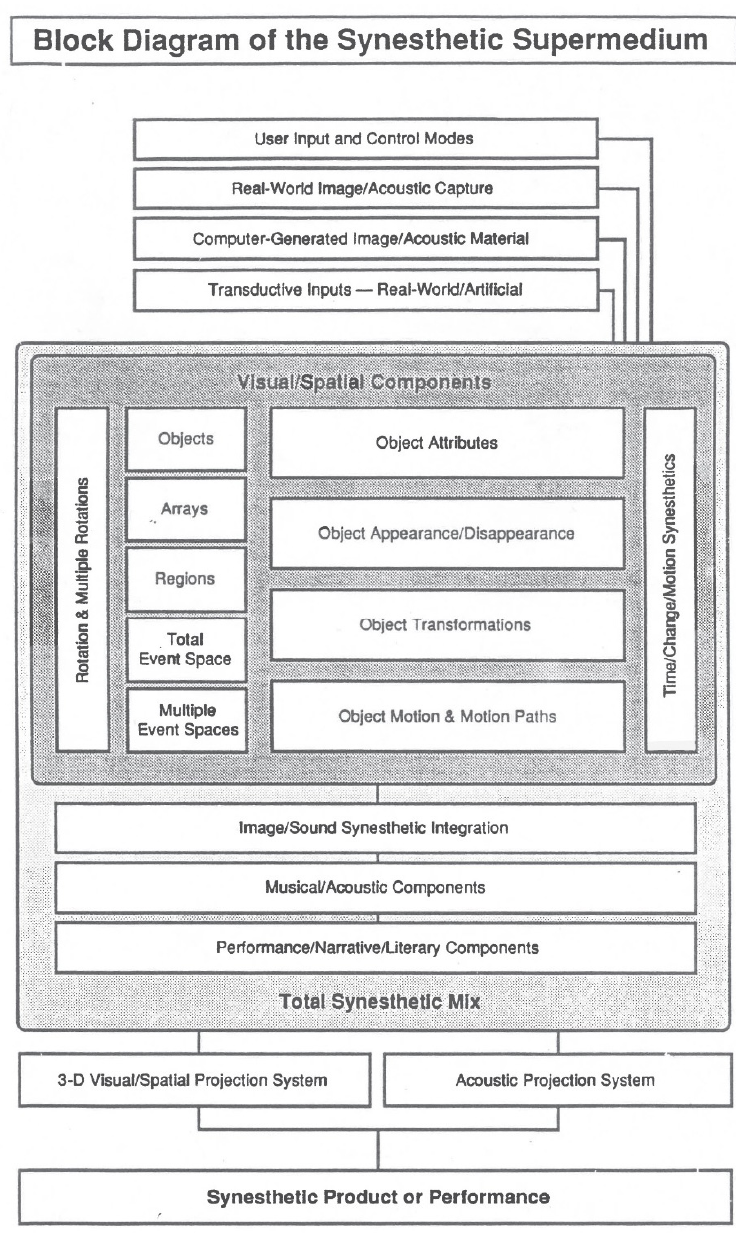
Figure 10. Robert Mallary, block diagram of the synesthetic Supermedium system, published 1990. © Estate of the artist.